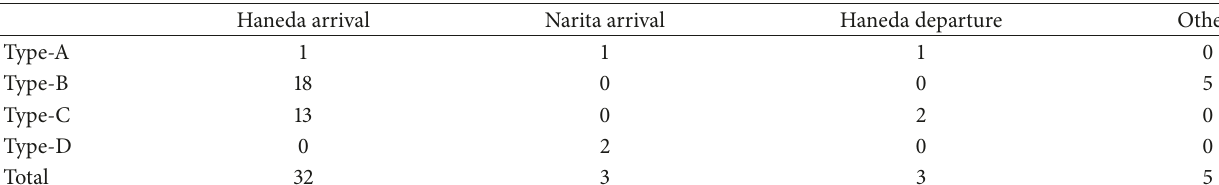
Table 6: Breakdown of 43 long flights.